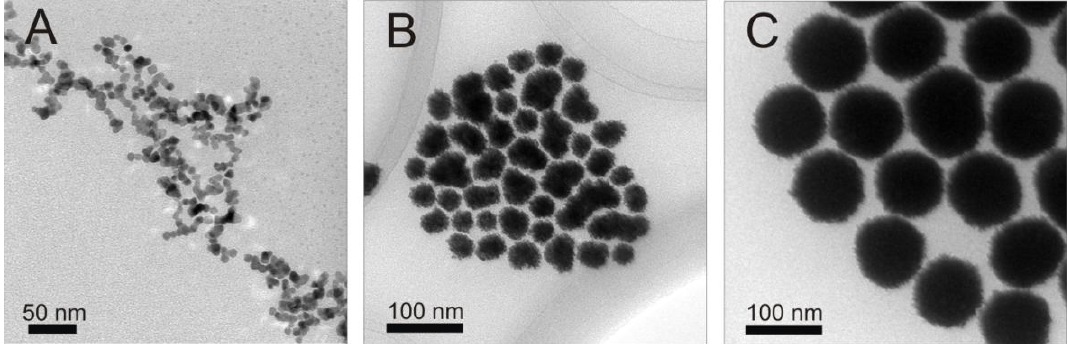
Figure 1. TEM images of platinum nanoparticles with a size of 4.5 ( A ); 31.3 ( B ); and 99.3 ( C ) nm.